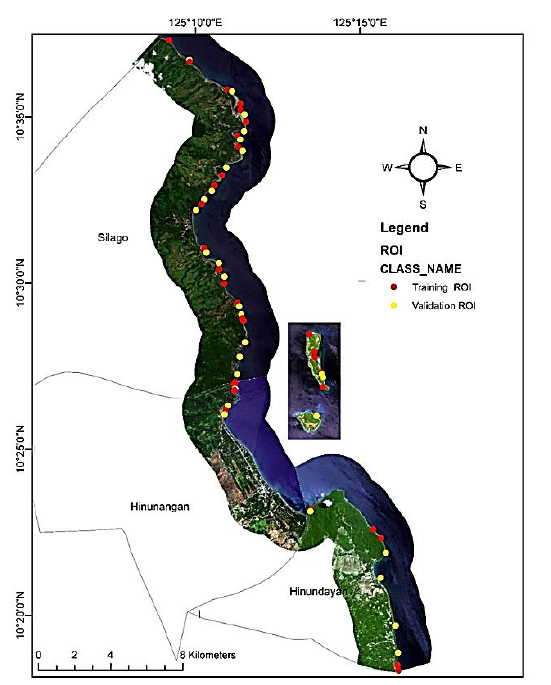
Figure 2. Locations of training and validation ROIs